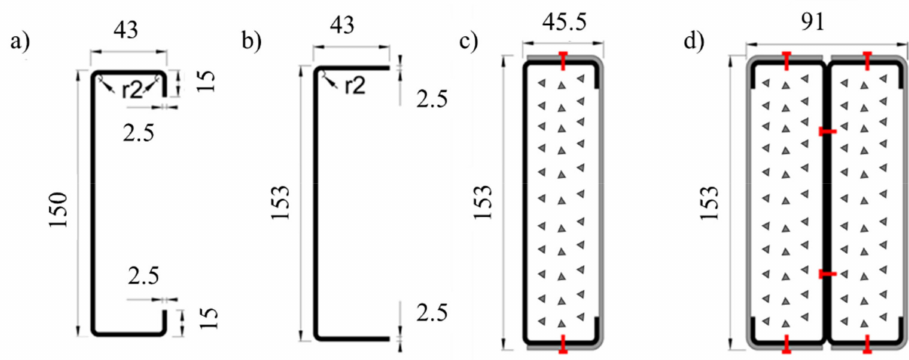
Figure 1. ( a , b ) Dimensions of the individual cross-sections. ( c , d ) Tested composite cross-section shapes. ( c ) Composite R-section. ( d ) Composite